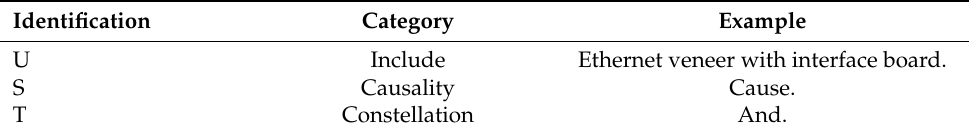
Table 3. Entity Relation Corpus Tagging.